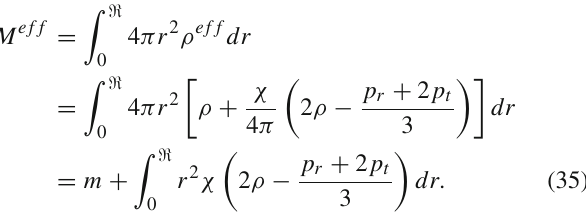
Fig. 9 Variation of dM PSRJ 1614–2230